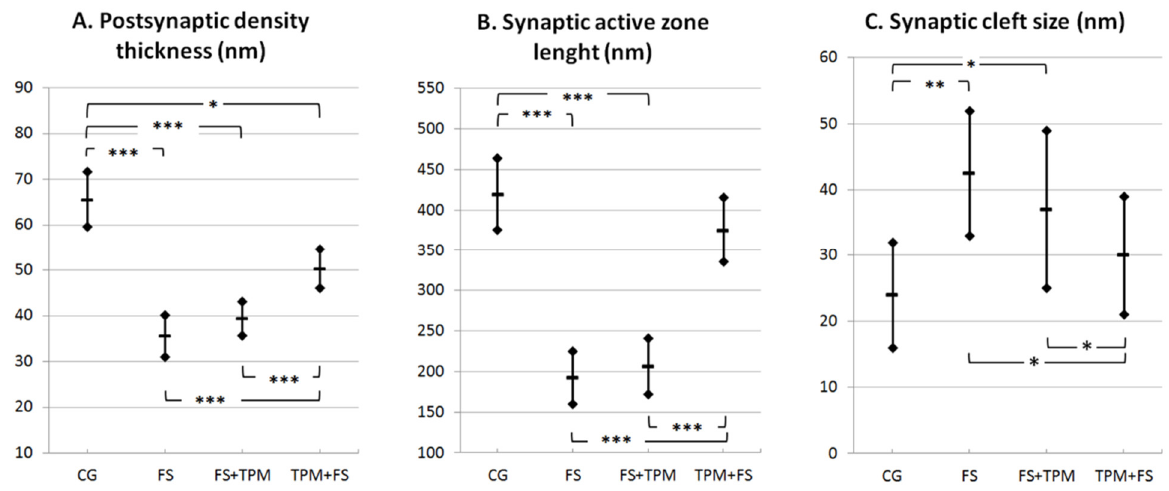
Figure 6. Measurements of postsynaptic density thickness ( A ), synaptic active zone length ( B ), and synaptic cleft size ( C ) in the control group (CG), hyperthermia-induced seizure group (HS), HS group with administrated topiramate (HS + TPM), and group with TPM administration before HS induction (TPM+HS). The median values and interquartile ranges are shown. ( A ) PSD thickness in each group was 65.3 ± 6.1 nm in the CG; 35.5 ± 4.4 nm in HS; 39.2 ± 3.7nm in HS + TPM; and 50.2 ± 4.3 nm in TPM + HS. Measurements significantly differed between the CG and HS ( p < 0.001), HS + TPM ( p < 0.001), and TPM + HS ( p < 0.05) groups, as well as between the TPM + HS and HS ( p < 0.001), and HS + TPM ( p < 0.001) groups. No further significant differences were found between any other groups. ( B ) The average synaptic active zone length in each group was 419.3 ± 44.2 nm in the CG; 192.5 ± 32.4 nm in HS; 206.1 ± 34.2 nm in HS + TPM; and 375.9 ± 40.3 nm in TPM + HS. Measurements significantly differed between the CG and HS ( p < 0.001), and HS + TPM ( p < 0.001) groups, as well as between the TPM + HS and HS ( p < 0.001), and HS + TPM ( p < 0.001) groups, and did not differ significantly between the CG and TPM + FS group ( p = 0.424). No further significant differences were found between any other groups. ( C ) Synaptic cleft width in each group was 24.3 ± 8.9 nm in the CG; 42.8 ± 10.1 nm in HS; 37.3 ± 12.9 in HS + TPM; and 30.1 ± 9.2 nm in TPM + HS. Measurements significantly differed between the CG and HS ( p = 0.0014), and HS + TPM ( p = 0.013) groups, as well as between the TPM + HS and HS ( p = 0.024), and HS + TPM ( p = 0.041) groups. No further significant differences were found between any other groups. A threshold significance level: * - p ≤ 0.05; ** - p ≤ 0.01, *** - p ≤ 0.001.